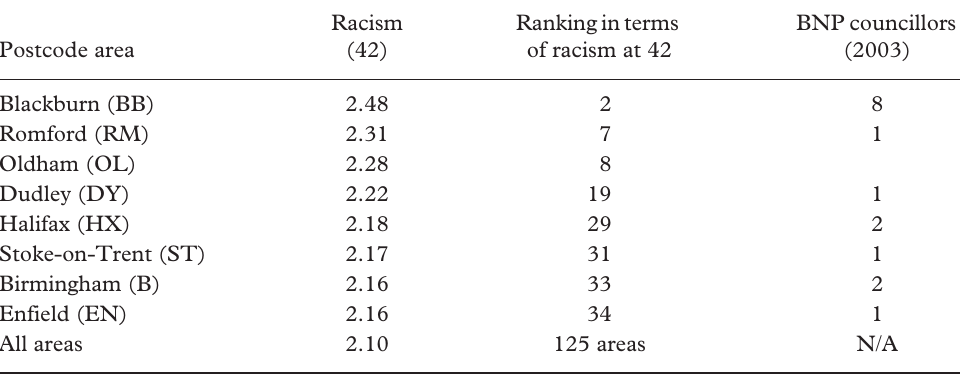
Table 1. Support for the BNP by mean level of racism in that